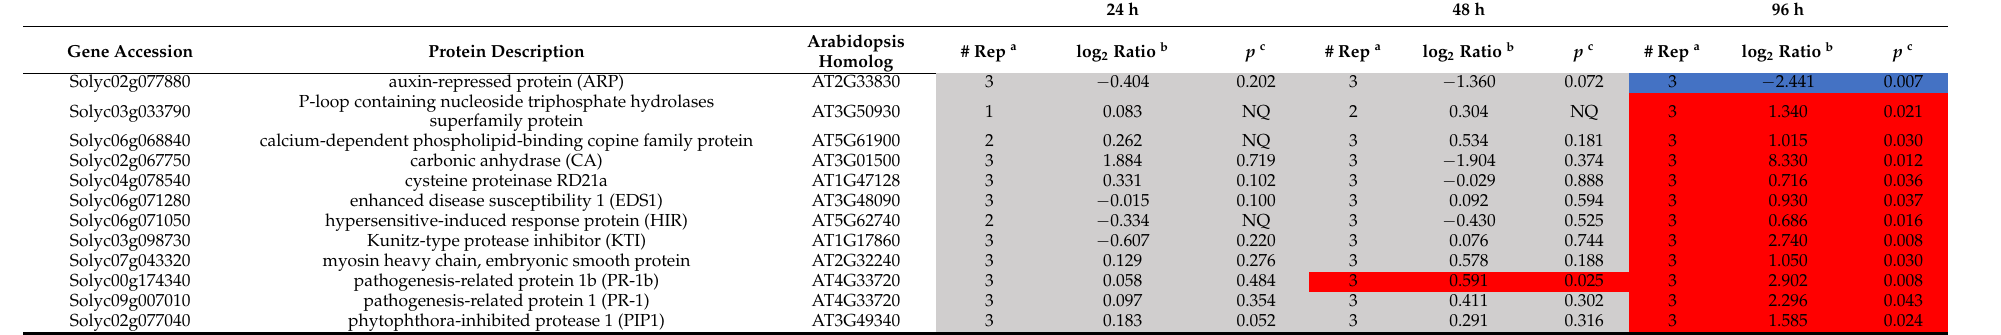
Table 2. Proteins involved in immune regulation with a significant change in abundance at 24, 48 and 96 h post-inoculation with P. infestans